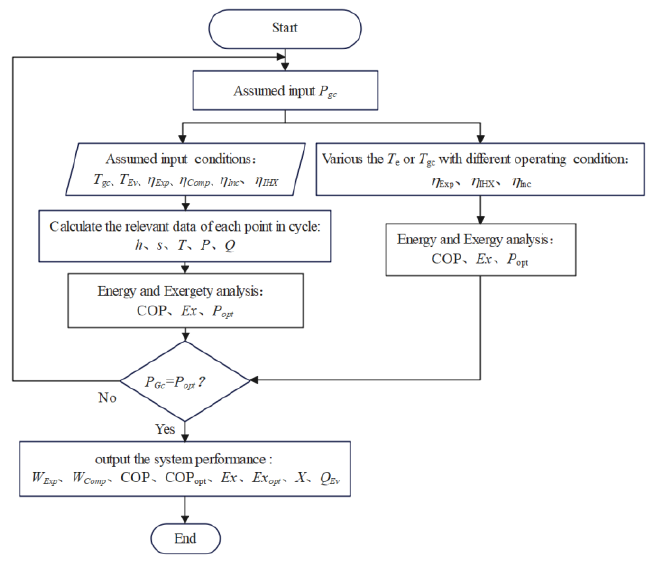
Figure 1. Schematic diagram of internal heat exchanger on two-stage compression trans-critical CO 2 refrigeration cycle combined with expander and intercooling. ( a ) System flow chart. ( b ) Sys- tem P - h diagram.